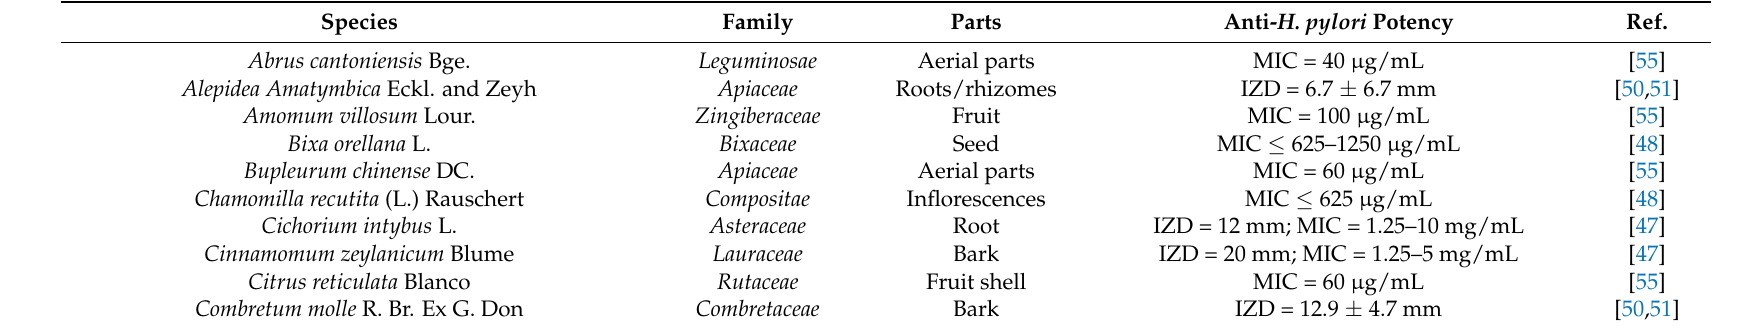
Table 3. Plant ethanolic extracts with anti- H. pylori